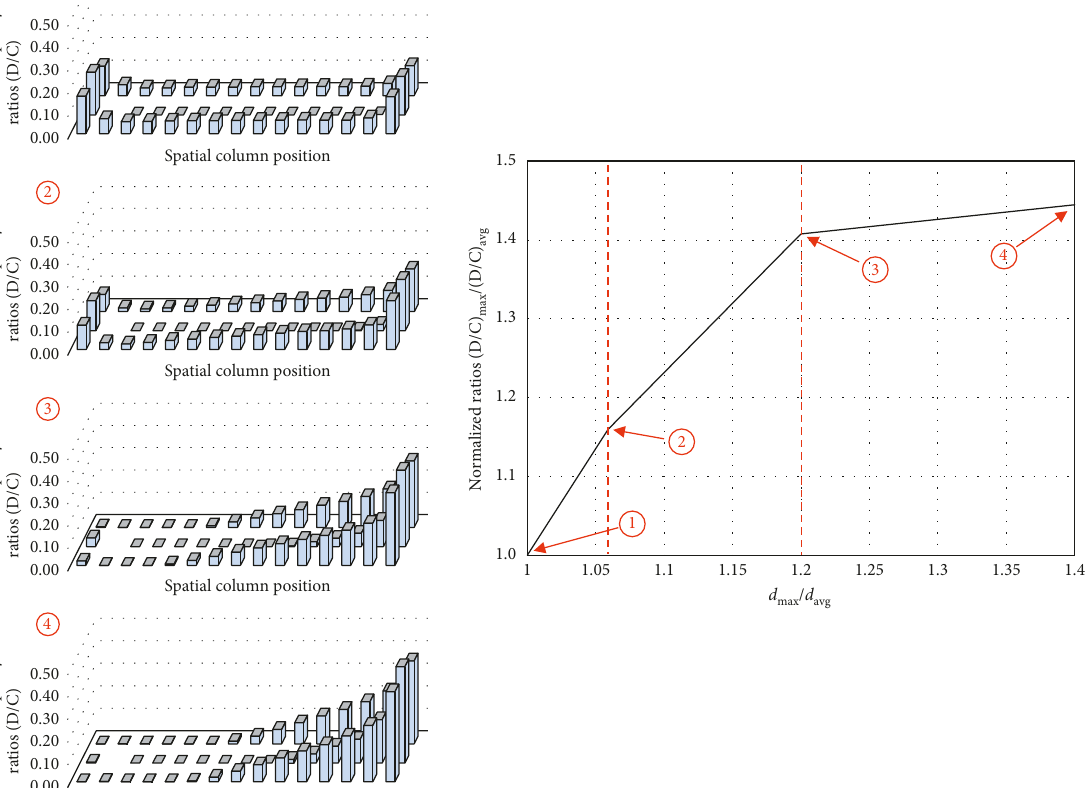
Figure 15: Normalized demand to capacity ratios (D/C) max /(D/C) avg , calculated by means of nonlinear dynamic analyses, at varying δ max / δ avg provided by the equivalent linear static